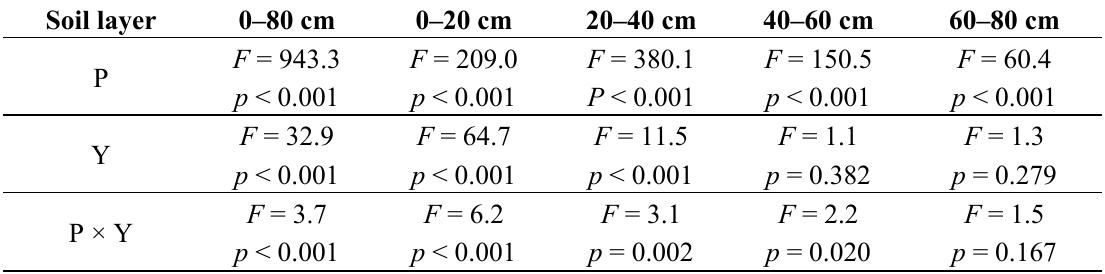
Table 2. Two-way repeated measures ANOVA results for planting treatment (P) and year (Y), on total soil C (t·ha − 1 ) to 80 cm, and at 20 cm increments. Degrees of freedom for main effects and their interactions were F 4,40 , and F 16,40 ,